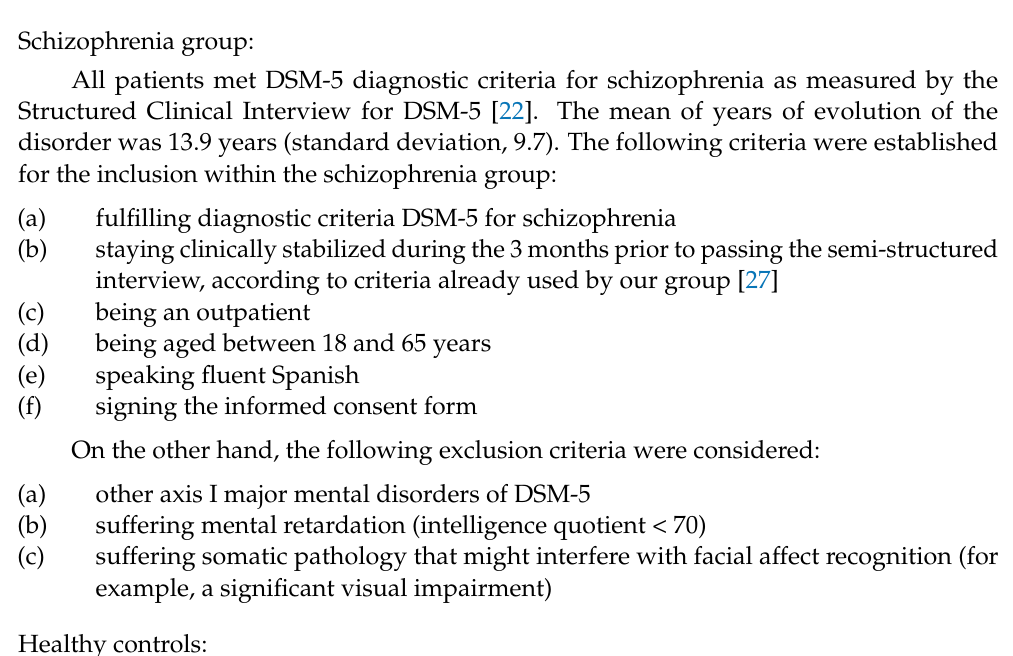
Table 2. Clinical data of the samples. Patients treated with atypical antipsychotics only 55 (98.2%) Patients treated with typical antipsychotics only 0 (0.0%) Patients treated with atypical and typical antipsychotics 1 (1.8%) Chlorpromazine equivalents 380 ± 53.6 mg/day Age of onset of the